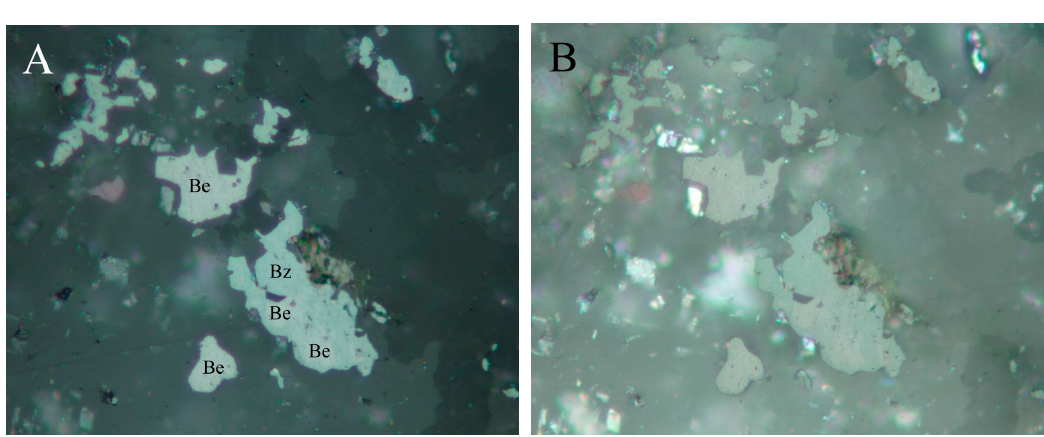
Figure 9. Bellidoite (Be) euhedral grains in association with bluish berzelianite (Bz). Reflected light, ( A ) one polarizer, and ( B ) partly-crossed polarizers. Field of view 210 μ m. P ř íbram, from a dump of shaft 16. Photo by P. Škácha.